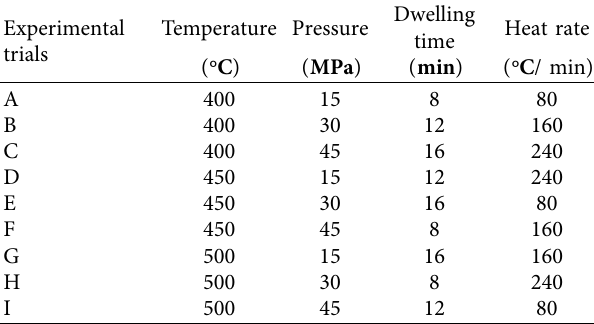
Table 2: Design of the